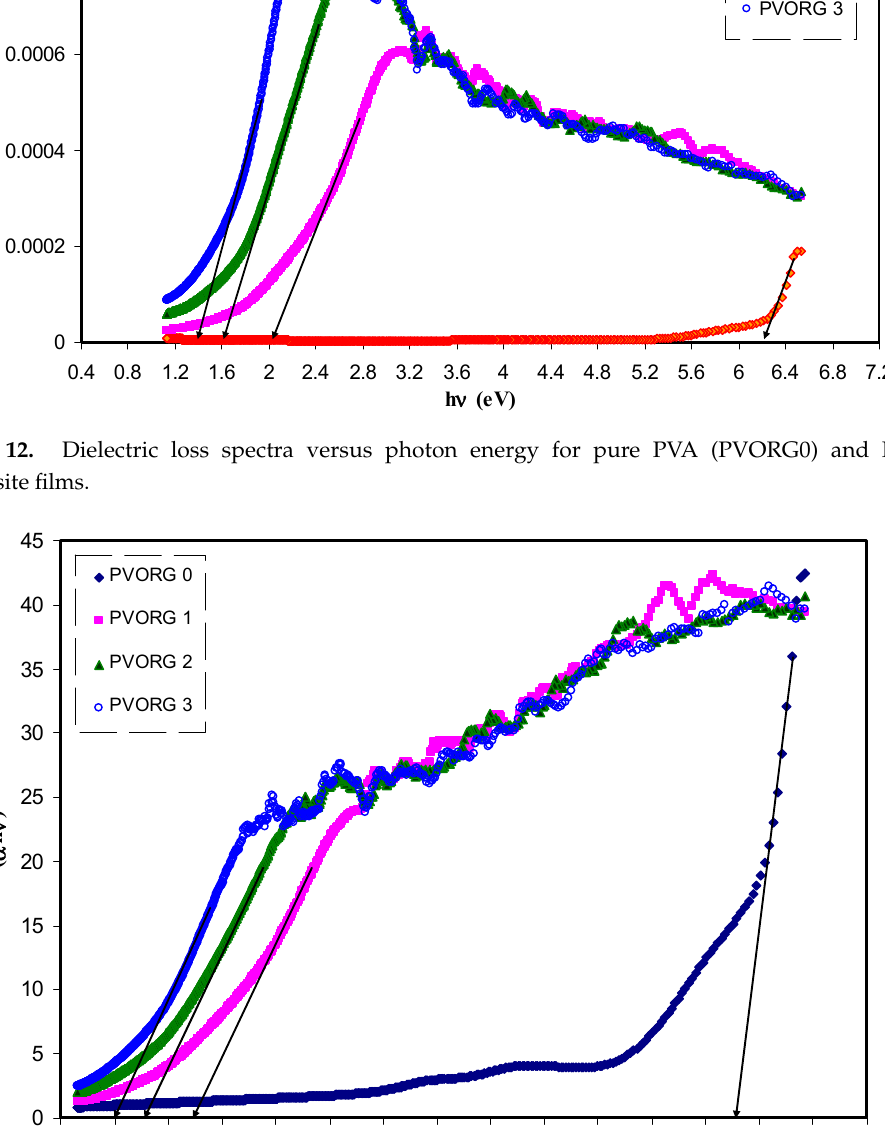
Figure 14. Plot of ( α h υ ) 2 vs. photon energy for pure PVA (PVORG0) and PVA composite films.